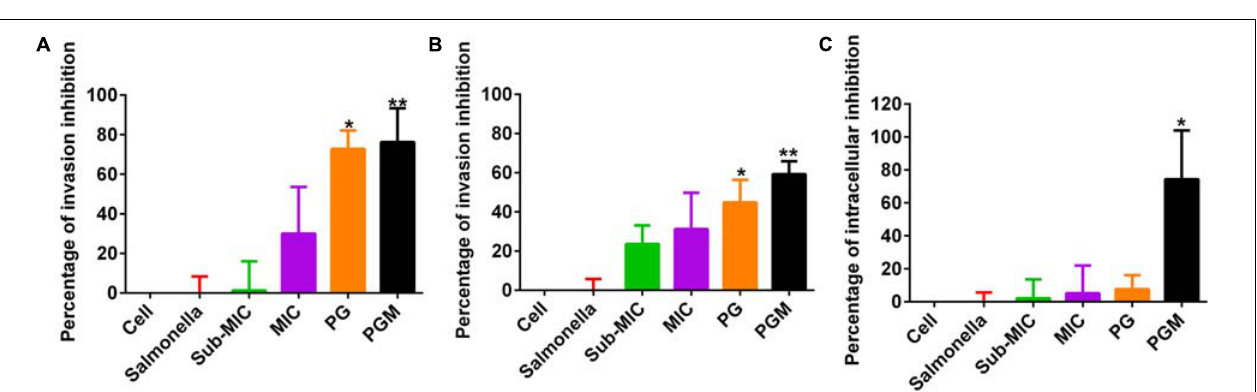
FIGURE 2 | Time-Kill assay of pyrogallol alone and in combination with sub-MIC of MAR against different strains of Salmonella Typhimurium. (A) ATCC 14028 (B) susceptible field isolate (S-2), and (C) intermediately resistant field isolate (S-15). Sal: non-treated Salmonella Typhimurium control; SUB: treated with sub-MIC of marbofloxacin alone; PG-64: treated with only pyrogallol (64 µ g/mL); PG-128: treated with only pyrogallol (128 µ g/mL); PG-256: treated with only pyrogallol (256 µ g/mL); PGM_64: treated with a combination of pyrogallol 64 µ g/mL and sub-MIC of marbofloxacin; PGM_128: treated with a combination of pyrogallol 128 µ g/mL and sub-MIC of marbofloxacin; PGM_256: treated with a combination of pyrogallol 256 µ g/mL and sub-MIC of marbofloxacin.